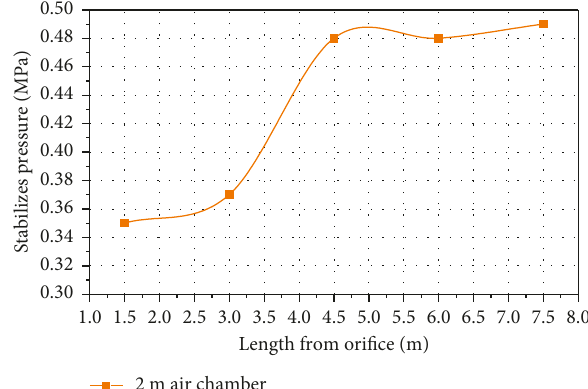
Figure 6: Stable pressure change in the 2-meter gas chamber. Figure 5: A diagram of the steady pressure change in the 1-meter